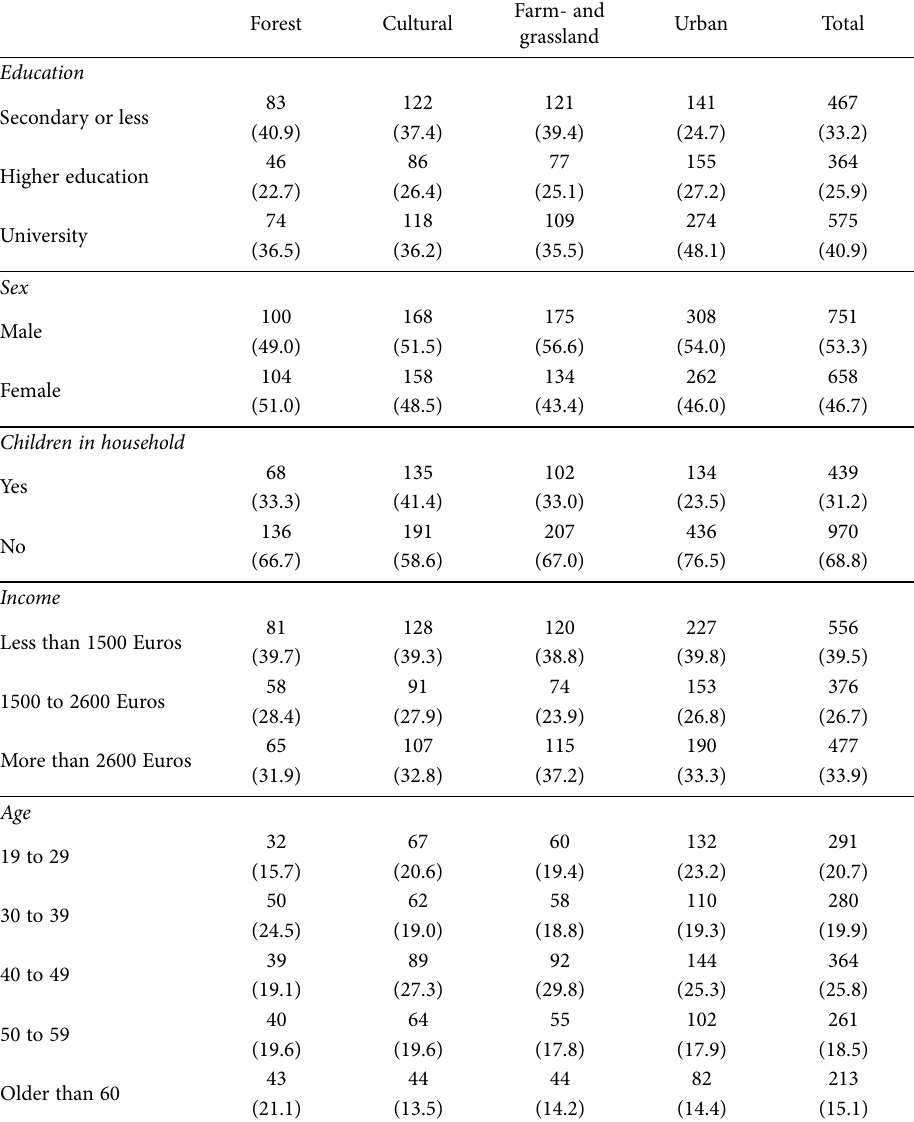
Table 3. Frequencies and column percentages (in parentheses) of socio-demographic variables. Farm- and Forest Cultural grassland